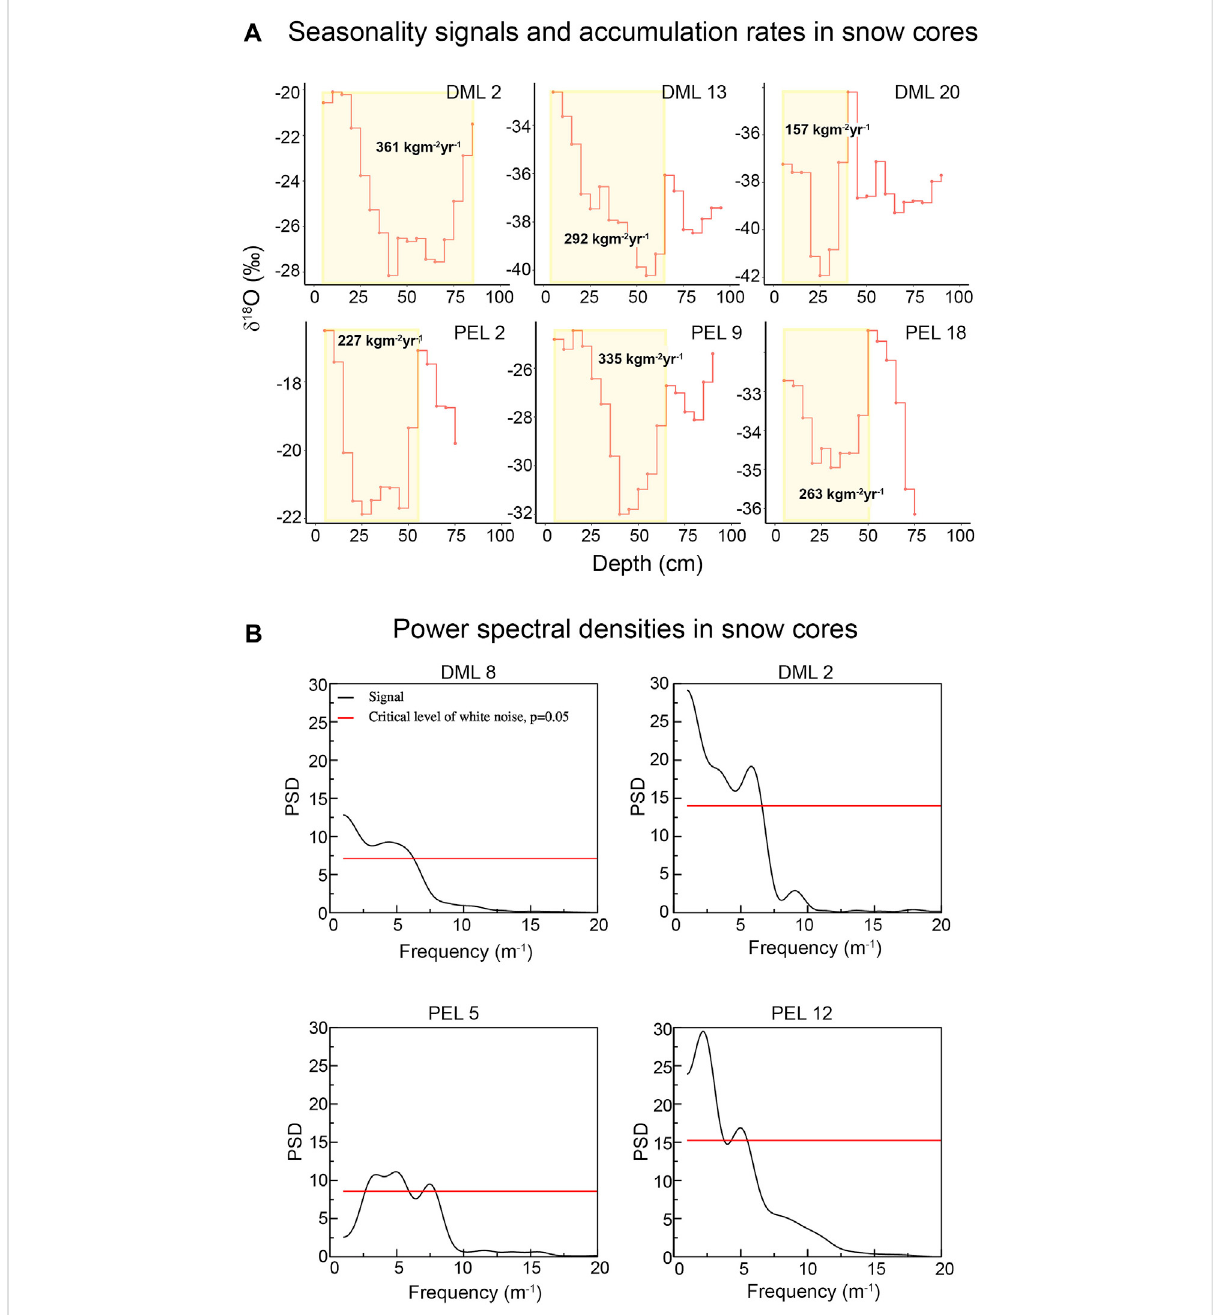
FIGURE 3 Acombinationofseasonalamplitudeplots (A) andpowerspectraldensity(PSD)plots (B) wereutilizedtoidentifyandeliminatespuriouspeaksin snow cores. While the seasonal amplitude plots revealed clear summer/winter patterns, the PSDs were used to avoid non-seasonal peaks. The shaded area indicates the estimated annual layer. Annual accumulation rates were calculated based on the annual layer depth and density